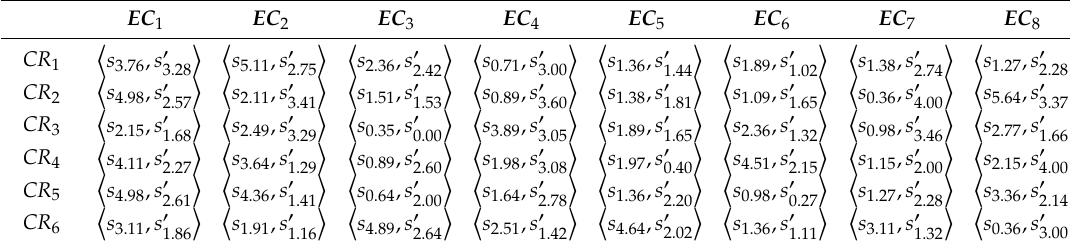
Table 9. The comprehensive decision